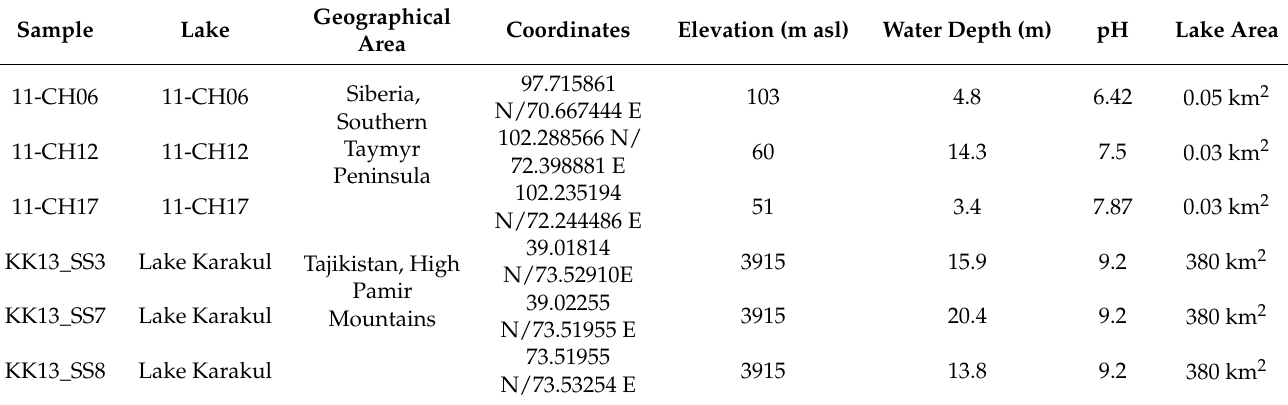
Table A8. Geographical provenance and characteristics of the surface sediment